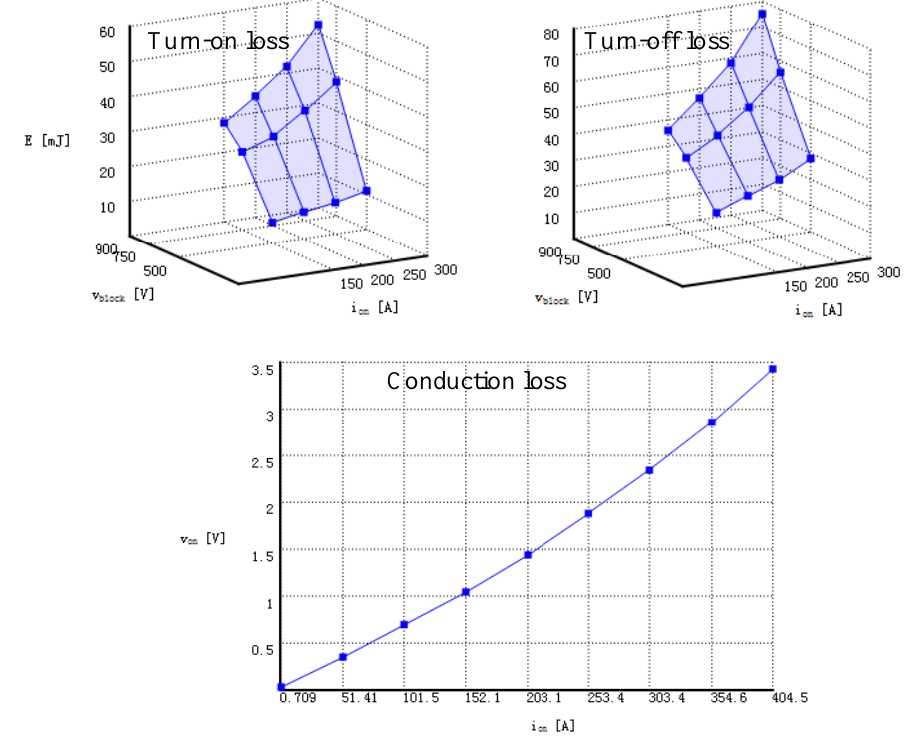
Figure 14. The device thermal description file.